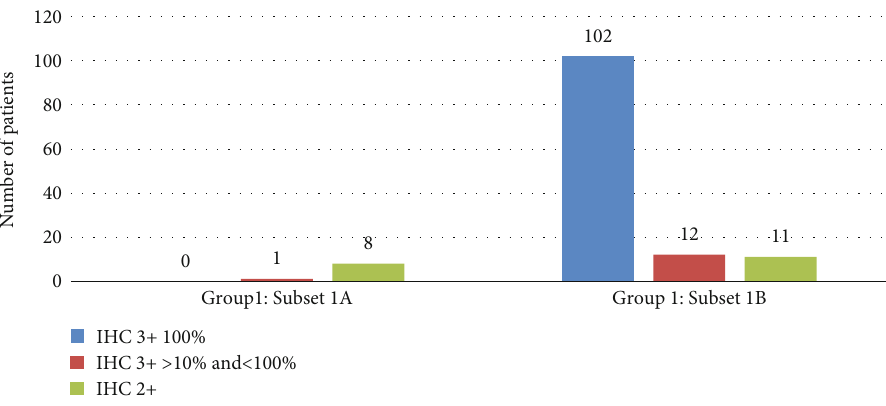
Figure 4: HER2 IHC staining characteristics of FISH Group 1 Subset A and Subset